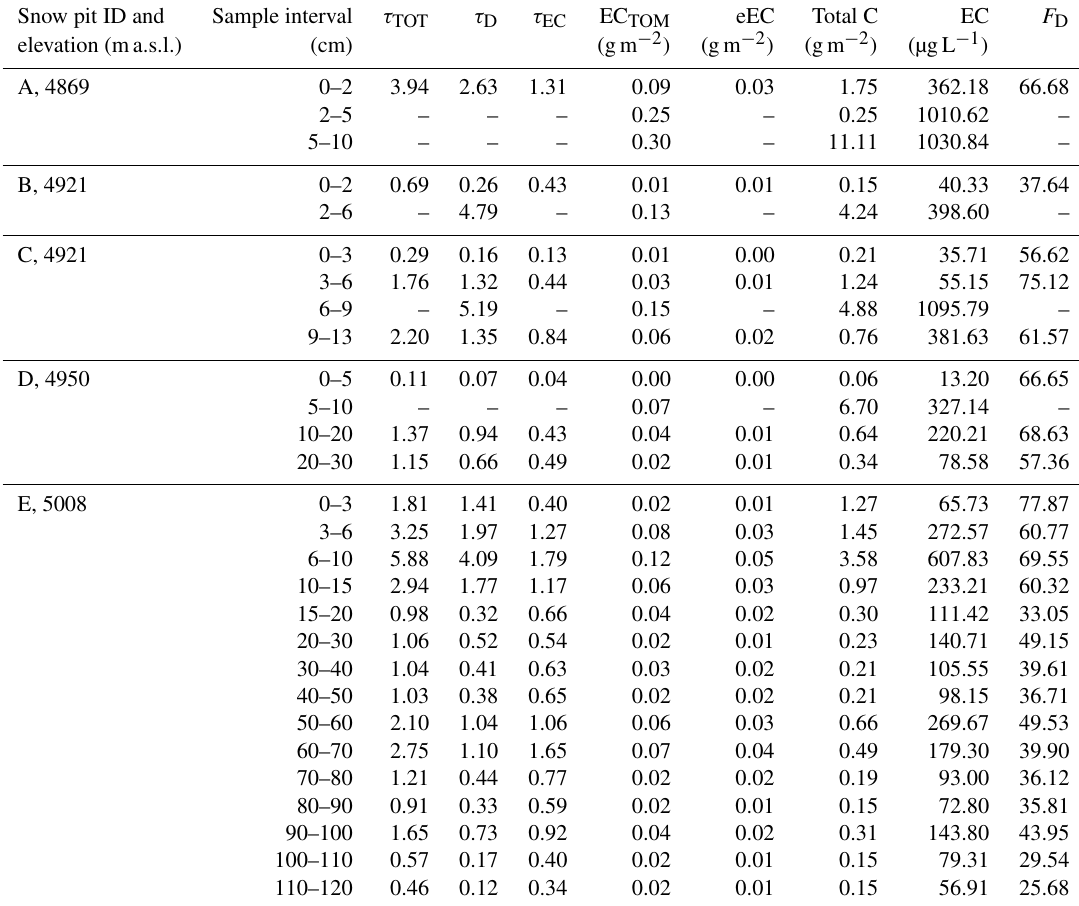
Table 1. Snow pit filter samples taken from Sunderdhunga in 2015. Durga Kot glacier snow pits are A–D and Bhanolti glacier snow pit E. Snow pit ID and Sample interval τ TOT τ D τ EC EC TOM eEC elevation (ma.s.l.)